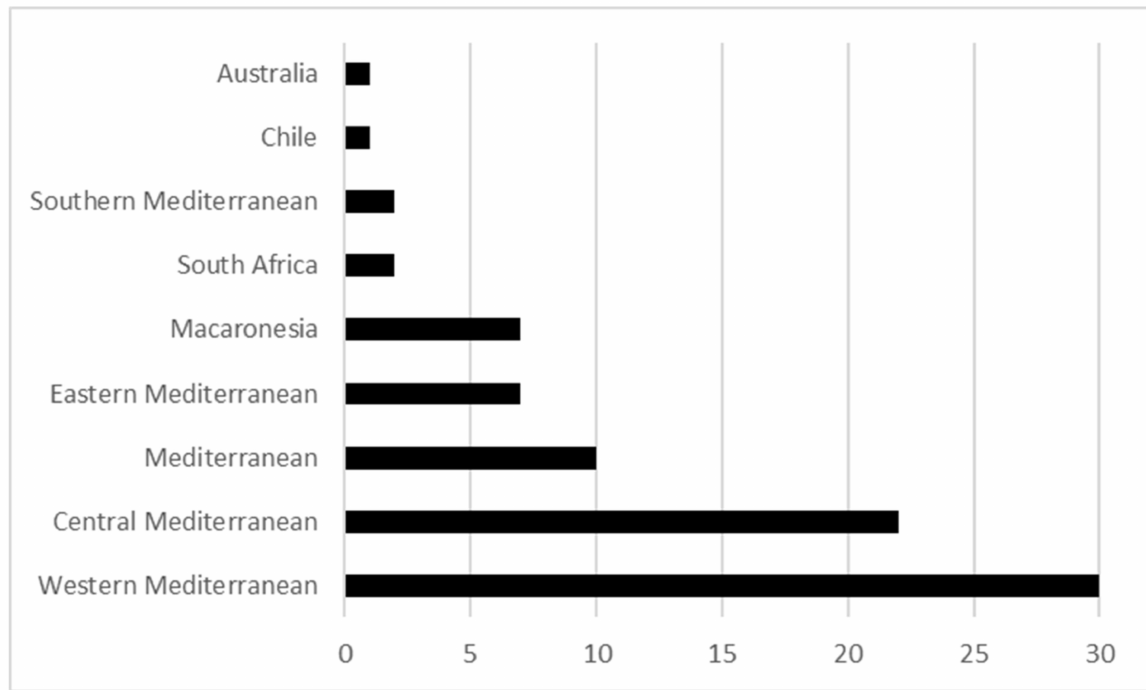
Figure 2. Graph showing the geographic distribution of the 78 documents reviewed within